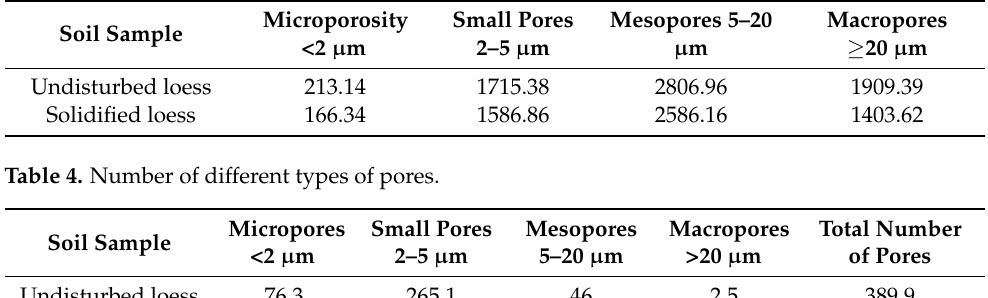
Figure 7. Picture of undisturbed loess after binarization.